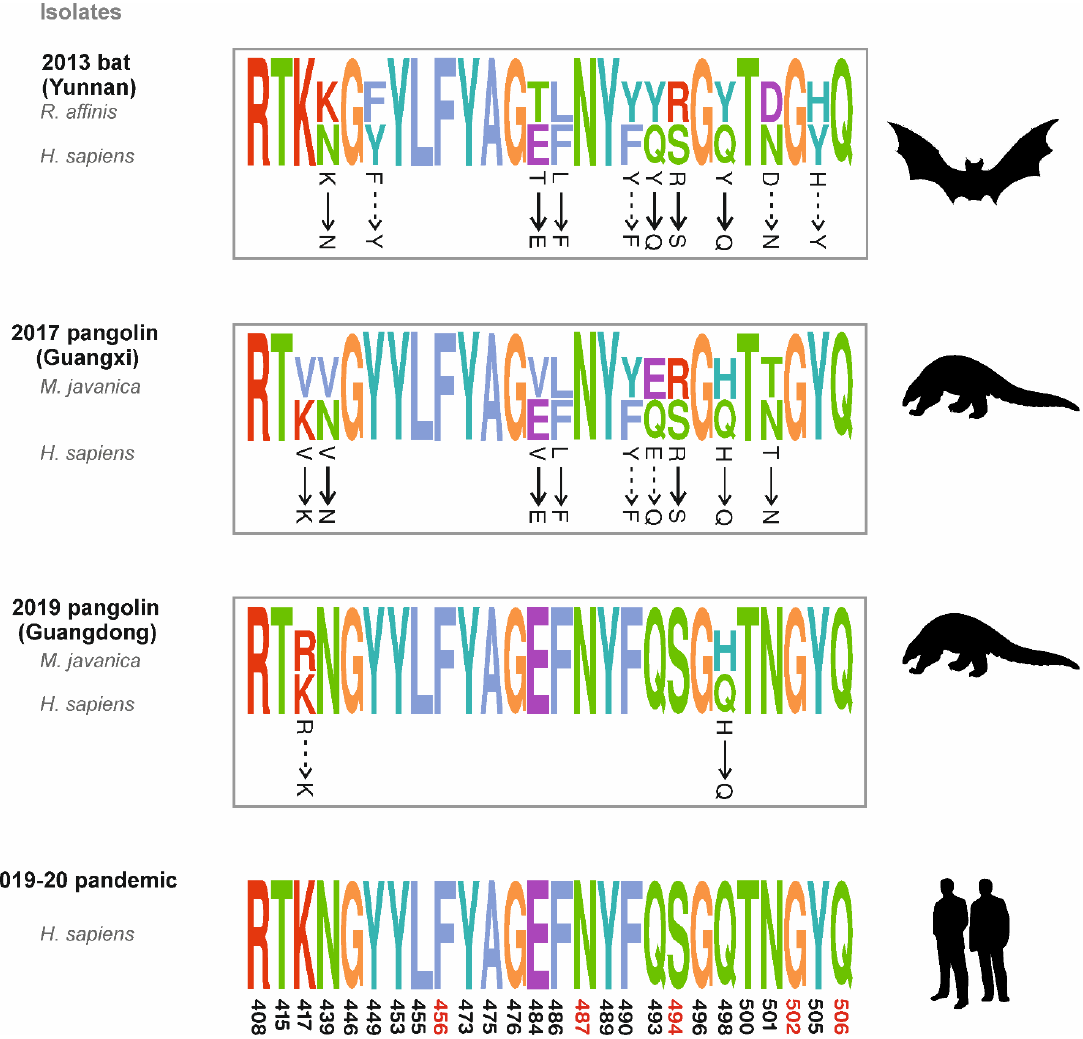
Figure 2. Detailed comparison of ACE2 binding RBD residues of Bat-CoV_RaTG13, Pangolin CoVs and SARS-CoV-2. The level of conservation is visualized using seqLogo, the letter height is proportional to the level of conservation of each residue in the sequence and the color code indicates similar physicochemical attributes. Residues important for ACE2 binding were obtained from [14,15,18] and mapped to the Wuhan-Hu-1 referenced SARS-CoV-2 S protein sequence (GISAID accession ID: EPI_ISL_402125). To avoid visual misinterpretation, in each block equal number of sequences from the species in comparison were taken. In the seqLogo graphic wherever two amino acids are aligned, SARS-CoV-2 sequence conservation is shown at lower position. Required mutations in bat and pangolin RBD for human adaptation are shown with arrows (Normal arrow: semi- conservative substitution; Dashed arrow: non-conservative substitution and Bold arrow: conservative substitution). Critical residue described in Xiao et al. [11] is marked in red color at the bottom of the figure. In porcine cell lines, mutation in the amino acid position 498 from Glu to His in GD Pangolin-CoV and GX Pangolin-CoV displayed significant reduction in infectivity with the human ACE2 by more than 200-fold as well as 160-fold, respectively [21,22]. In addition, mutation at the same residue 498 from Glu to Tyr in Bat-CoV has been shown to enhance the binding affinity of RBD to ACE2 [17]. These observations confirm that the Q498H mu- tation in SARS-CoV-2 spike could be a potential threat to humans. Both GD Pangolin-CoV